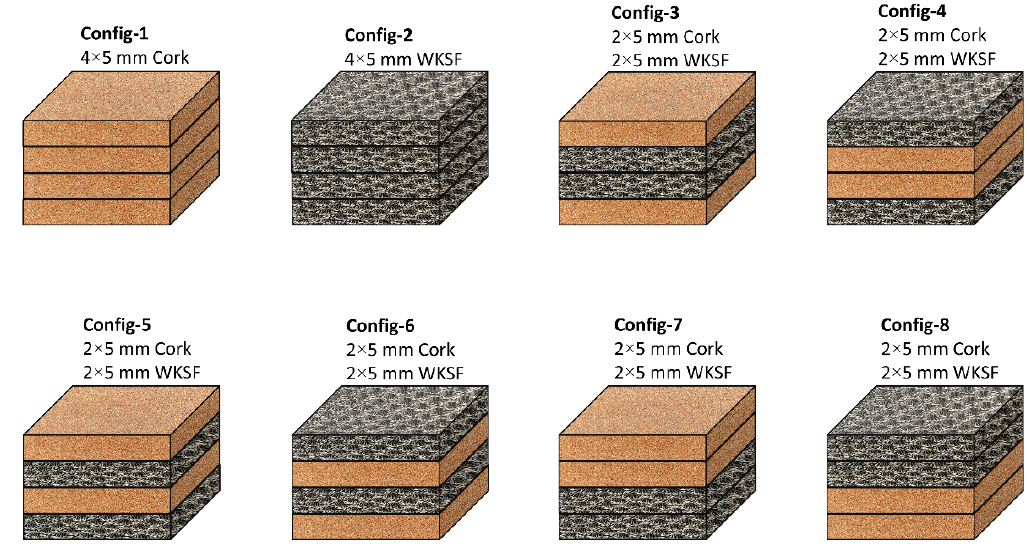
Figure 2. Multi ‐ layer composite configurations. Figure 2. Multi-layer composite